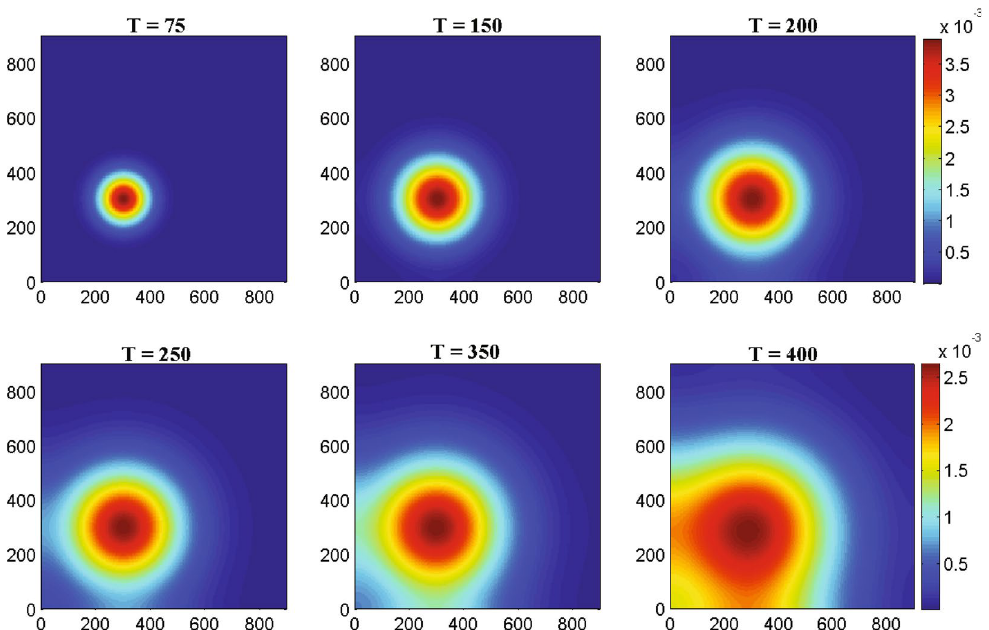
Figure 9. The two-dimensional numerical simulations describe the dynamics of cytotoxic T-lymphocytes cells density C T ( t , x , y ) at times corresponding to 75, 150, 200, 250, 350 and 400 h respectively. The simulation demonstrates the spatial distribution of cytotoxic T-lymphocytes density through the domain for an increasing value of time. Parameter values: D G = 55 , D M = 5 , D T = 400 , D C = D I = 25 and the other parameter values and initial conditions are presented in the Table